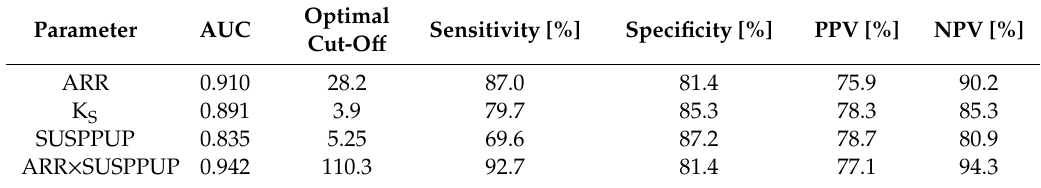
Table 4. Cut-o ff values, sensitivities and specificities as suggested by ROC curve analysis.